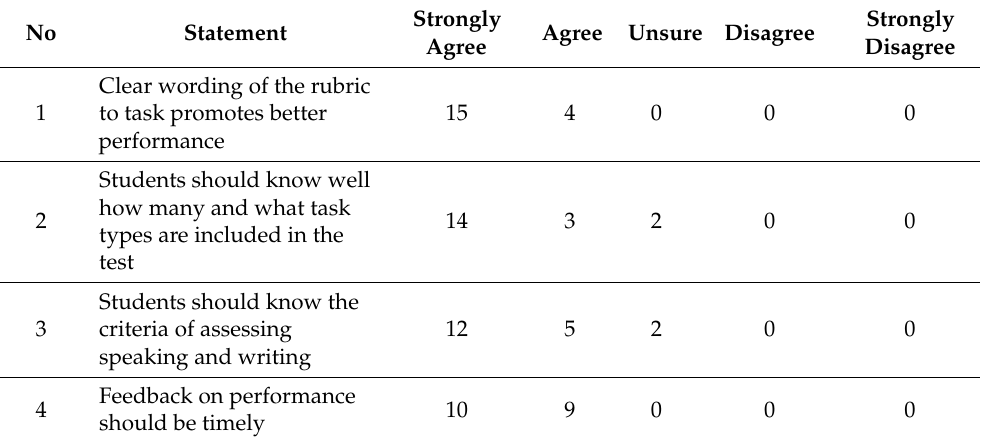
Table 7. Perceptions of GE course impact on acquisition of some testing